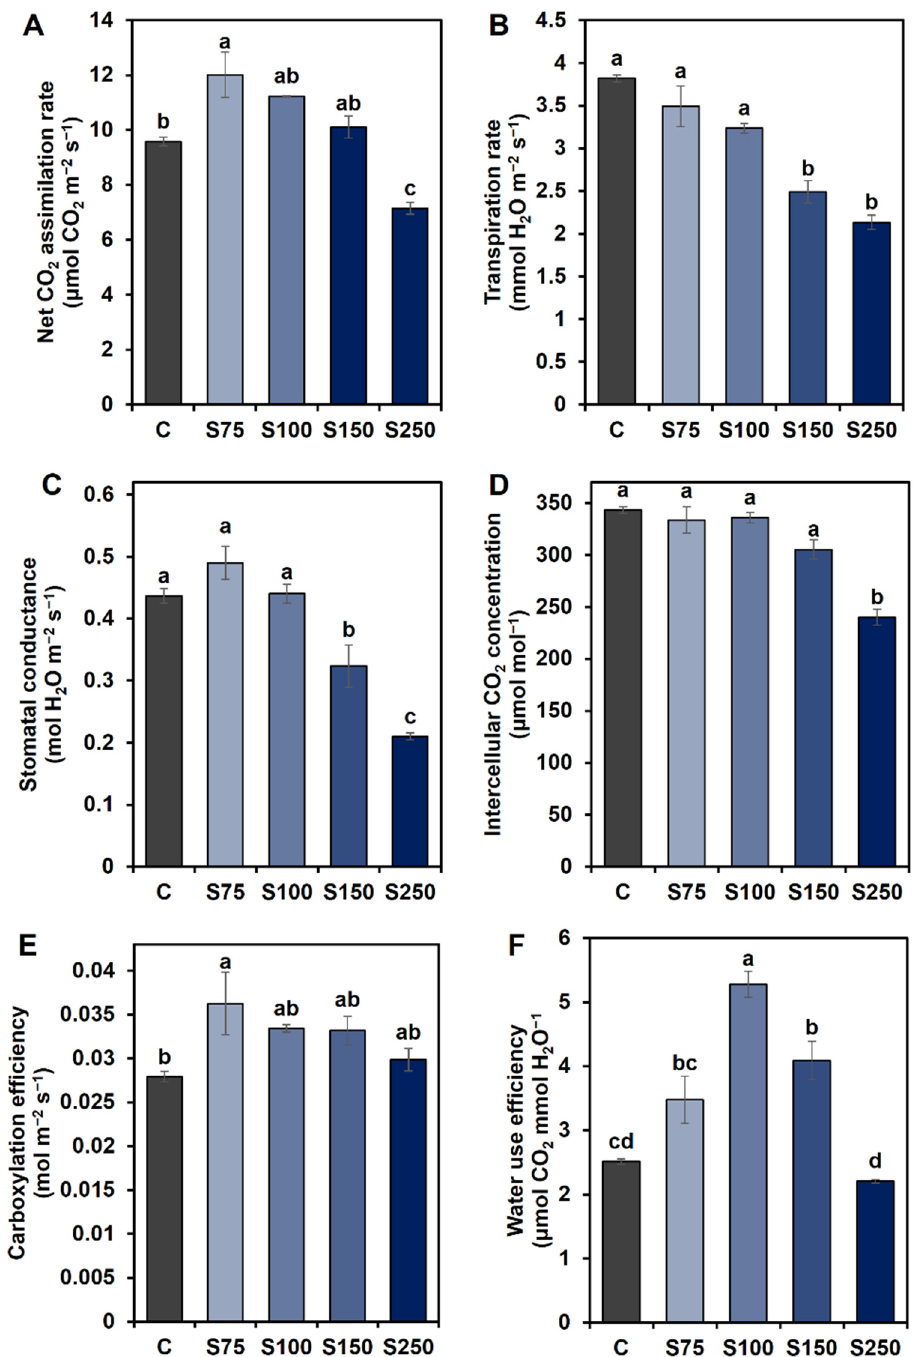
Figure 2. Effects of soil salinity on net CO 2 assimilation rate (A) ( A ); transpiration rate (E) ( B ); stomatal conductance (Gs) ( C ); intracellular CO 2 concentration (Ci) ( D ); carboxylation efficiency (A/Ci) ( E ); and water use efficiency (WUE) ( F ) in sugar beet after exposed to various salt concentrations for 95 days. Each bar represents the average of three independent replicates ( n = 3 ), and the error bar denotes standard errors. Statistically significant differences among different treatments are designated by various alphabetic letters based on Tukey's honestly significant differences test ( P < 0.05 ). Control (C), 0 mM NaCl; S75, 75 mM NaCl; S100, 100 mM NaCl; S150, 150 mM NaCl; S250, 250 mM NaCl. 3.4. Alteration of Leaf Total Chl Content, H 2 O 2 , and MDA Content by Salt Stress